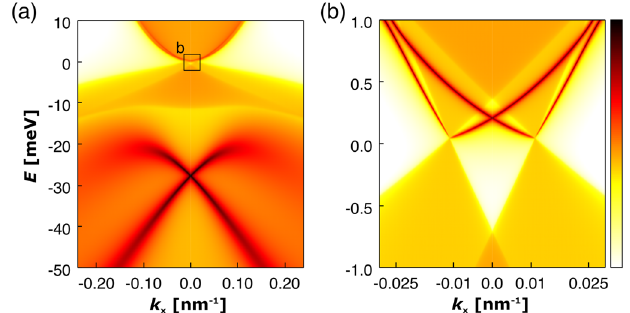
FIG. 2. (a) Band structure along the k x direction of the surface Brillouin zone of a semi-infinite thick slab of compressively strained HgTe ( ≈ 0 . 3% ) from density functional theory. Spectral features in dark red show prominent surface character, while lighter colours display the continuum of bulk states with relatively weaker projections onto the (001) surface. The sharp dark lines highlight the massless Volkov-Pankratov states and Dirac point stemming from the Γ 6 - Γ 8 band inversion. Because of the sharp interface and the absence of a Hartree potential in this calculations, the massive Pankratov states are shifted to high energies and not visible here. (b) Enlargement of (a) around the Fermi level showing two Weyl points with the same chirality þ 2 . At large momenta, i.e., far from the Weyl points low-energy physics, the surface states originating from the Weyl nodes are the massless Volkov-Pankratov states that disperse in the unoccupied part of the spectrum [cf. the surface states above the Fermi level in (a)]. The color code identifies the spectral function A ð k ; ω Þ ¼ ð − 1 = π Þ Im G ð k ; ω Þ , where G ð k ; ω Þ is the mo- x x x surf surf mentum and energy resolved surface Green ’ s